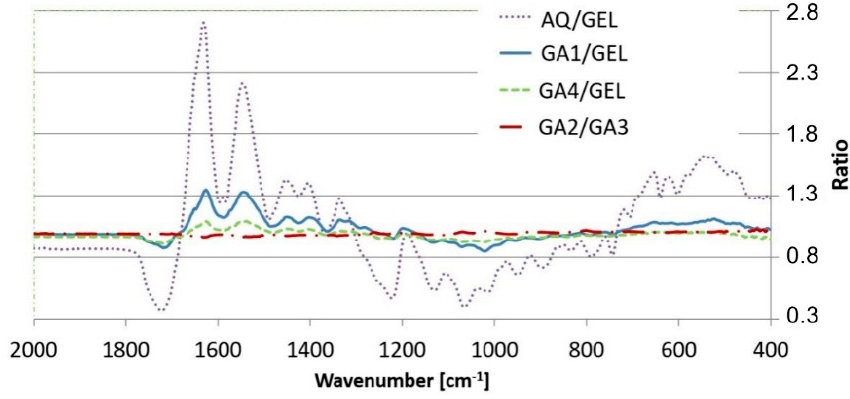
Figure 7. Peak intensity ratios of the films.